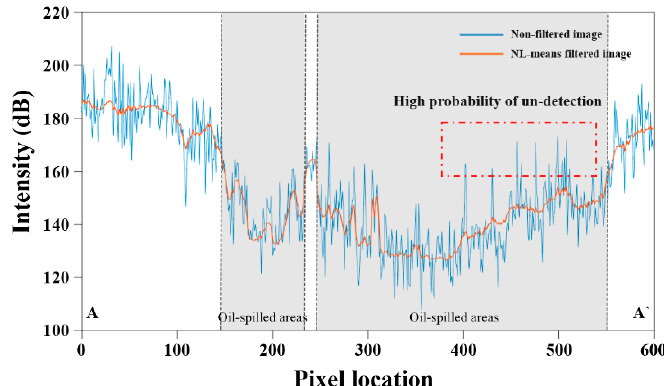
Figure 4. Profile map from A to A’. Points in the red box indicates a pixel that has high possibility of un-detection. Blue color line is generated by value of non-filtered image pixel and value of NL-means filtered image is drawn with orange color line.